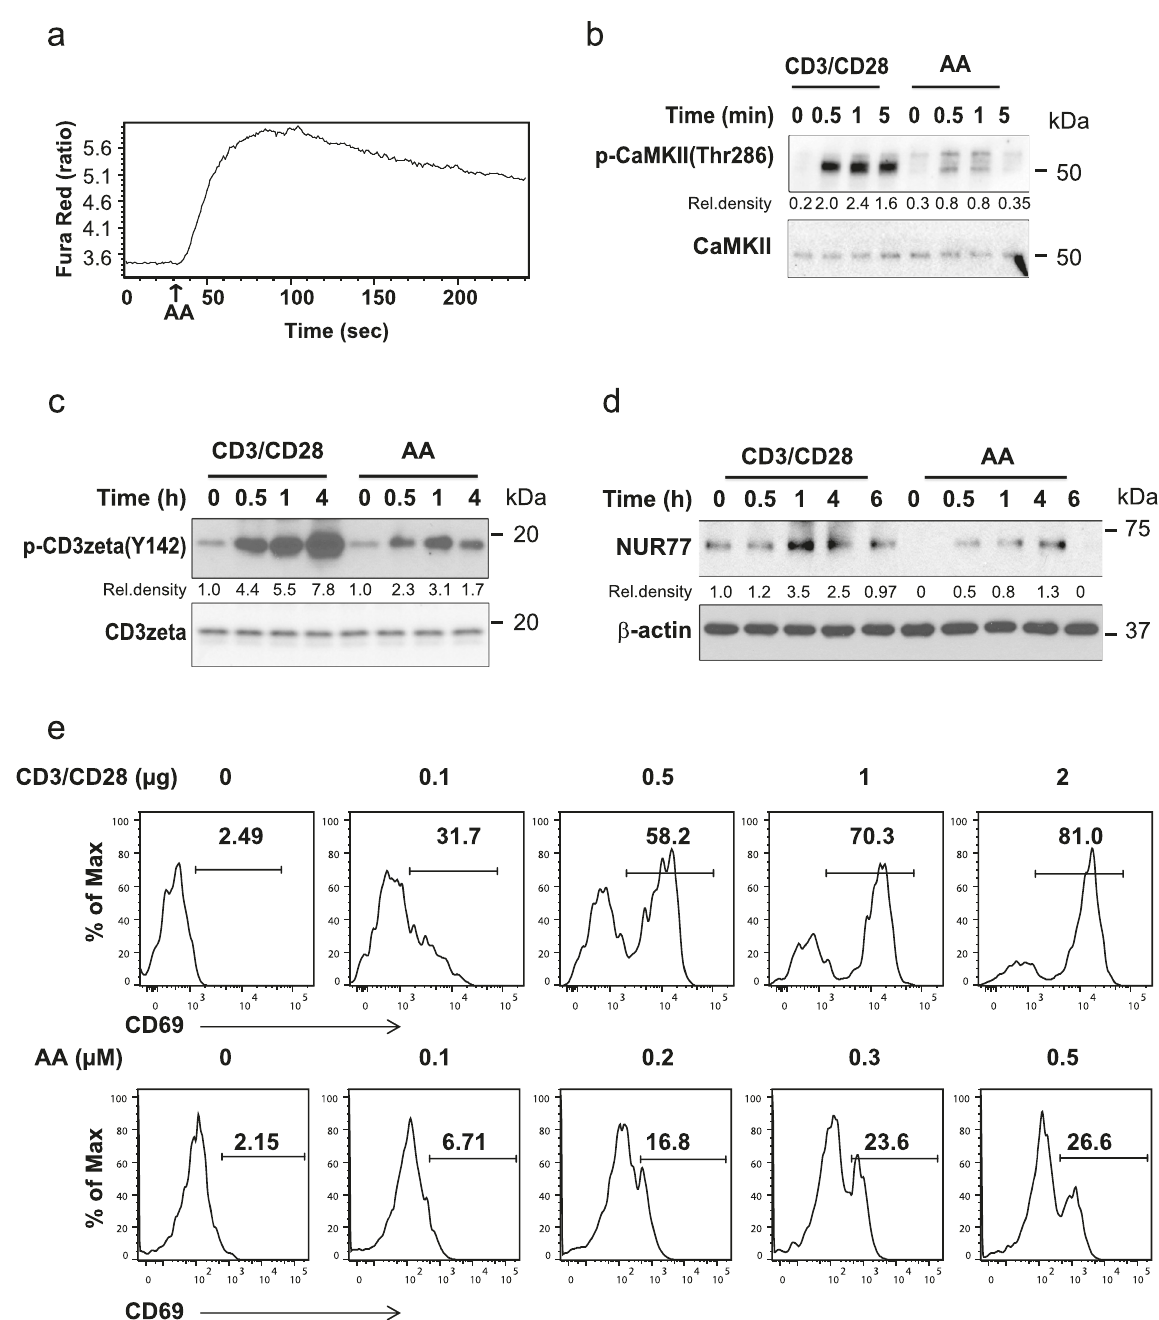
Fig. 3 Functional consequences of arachidonic acid stimulation of naive CD4 + T cells. a Flow cytometry analysis of AA-induced Ca 2 + in fl ux after stimulation with 0.1 µ M AA. The ratio of shifts in Fura Red fl uorescence (at 406 and 532 nm) is shown at indicated times. b Immunoblot analysis of Ca 2 + -dependent CaMKII phosphorylation in CD4 + naive T cells after crosslinking with immobilized 100 ng/ml anti-CD3/CD28 mAb or 0.3 µ M AA stimulation. c Immunoblot analysis of CD3 ζ (Y142) phosphorylation in CD4 + naive T cells after 0.3 µ M AA activation or stimulation with immobilized 100 ng/ml anti-CD3/CD28 mAb. d Immunoblot analysis of NUR77 expression in naive CD4 + T cells after 0.3 µ M AA or 100 ng/ml anti-CD3/CD28 mAb stimulation. All uncropped Western blots in Supplementary Fig. 9. e Flow cytometric analysis of CD69 expression in naive CD4 + T cells stimulated by increasing concentrations of AA for 3 min and then cultured for 24 h. Anti-CD3/CD28-induced CD69 expression was used as a positive control. Results in a – e are each representative of two